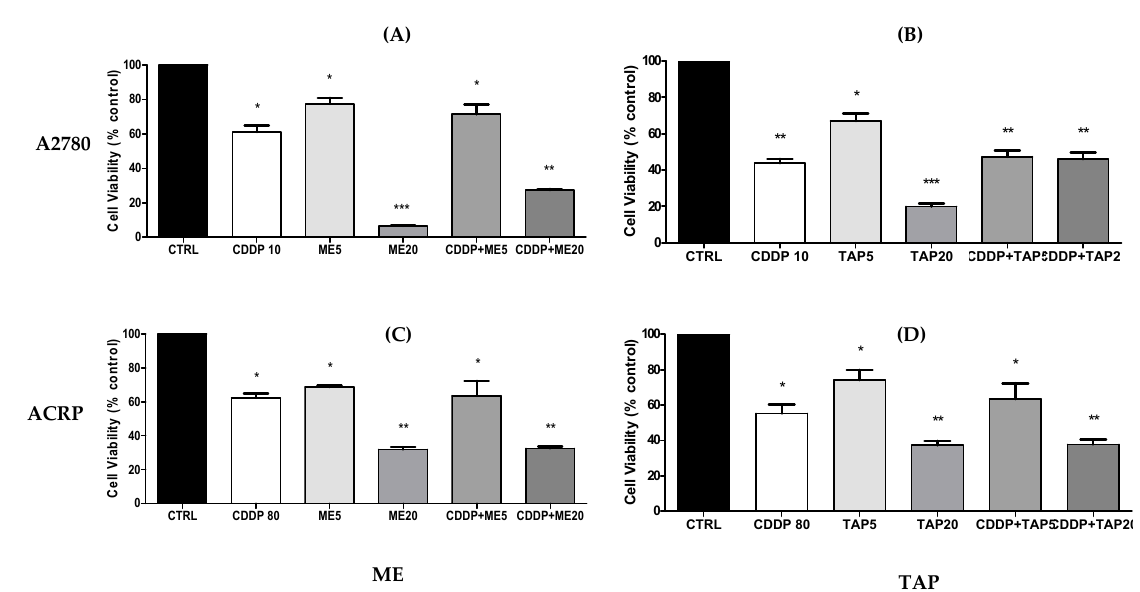
Figure 5. E ff ect of ME and TAP on CDDP of A2780 and ACRP cell viability. E ff ect of ME ( A , C ) and TAP ( B , D ) at the concentrations of 5 (ME5 or TAP5) and 20 mg / mL (ME20 or TAP20) on cell viability of A2780 ( A , B ) or ACRP ( C , D ) after 24 h of isolated or combined treatment with CDDP at 10 µ M for A2780 (CDDP10) or 80 µ M for ACRP (CDDP80) using MTT assays. The results are expressed as mean ± standard deviation of three independent experiments. Significant di ff erences between the untreated cells (CT) and those incubated with the respective extracts were compared by one-way ANOVA followed by the Tukey’s post-test (* p < 0.05; ** p < 0.01; *** p < 0.001).